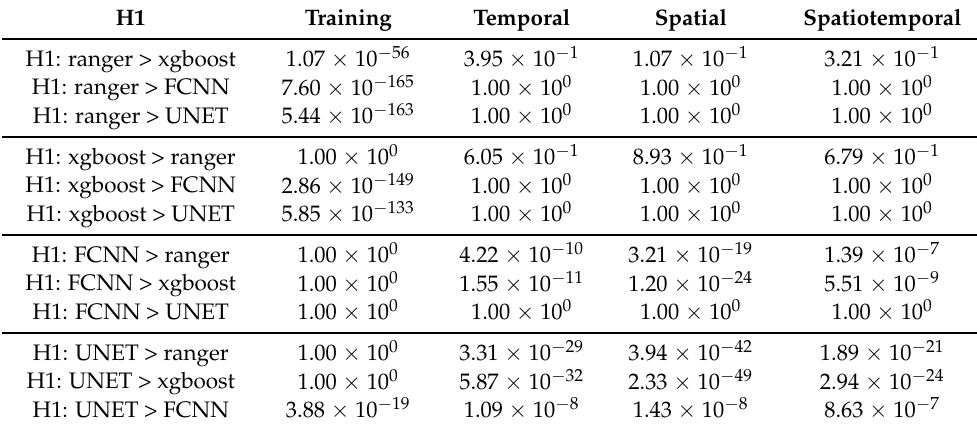
Table 7. Summary of Mann–Whitney U